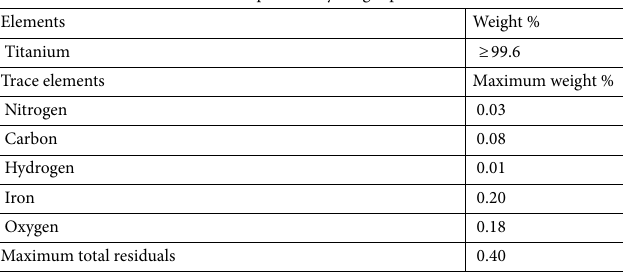
Table 2. Elemental analysis of titanium grade 1 wire used in testing provided by TEMCo Industrial 34